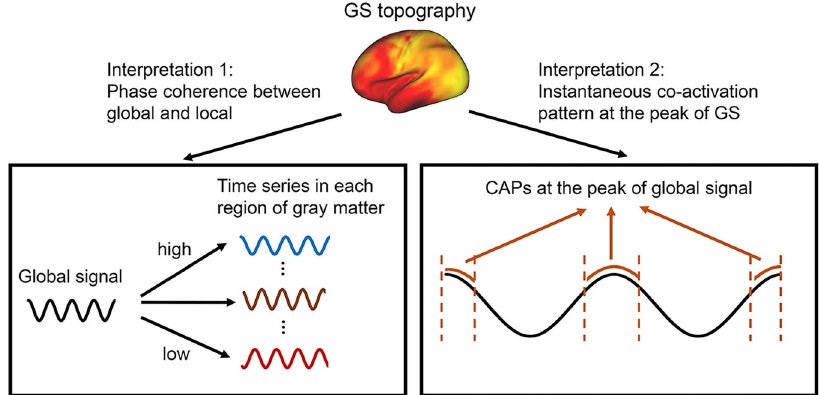
Fig. 3 Two interpretations of GS topography. Interpretation 1 suggests that the GS topography is the degree of the phase coherence between global and local activity. Interpretation 2 suggests that the GS topography is constituted by the co-activation patterns (CAPs) of different networks as being phase- locked to the peak of GS, i.e., the instantaneous CAPs with zero-phase lag to GS. Global signal GS; Co-activation